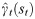
Surprise readouts.A) Example sequence with ot in red, st in black with st = 0 for the slow-switching regime and st = 1 for the fast switching regime, and the HMM filtering posterior γ^t(st) in between. The rare catch-trials are not plotted to facilitate a direct comparison between the HMM and DC models. B) The normalized probability estimates of the HMM TP1 and DC TP1 model with an observation half-life of 95, displaying differences in estimates arising from different adaptations to regime switches. C,E,G) The z-scored surprise readouts of the HMM TP1 models: predictive surprise (PS), Bayesian surprise (BS), and confidence-corrected surprise (CS). D,F,H) The z-scored surprise readouts of the DC TP1 models.